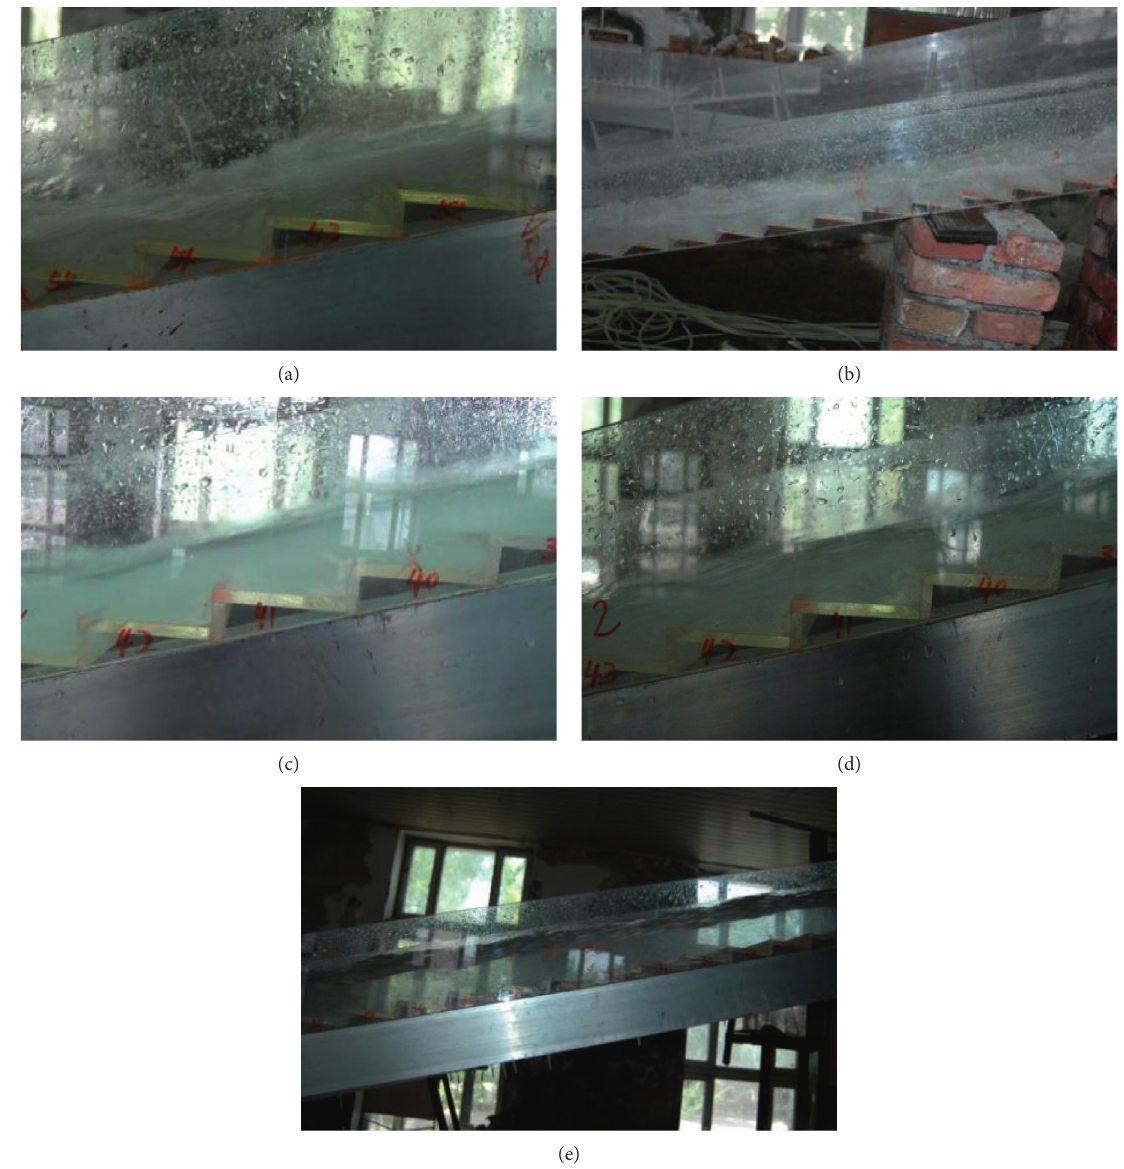
Figure 5: Flow state of water in the ladder section under different conditions. (a) Flow state under a 10-year flood. (b) Flow state under a 20- year flood. (c) Flow state under a 30-year flood. (d) Flow state under the design flood condition. (e) Flow state under collated flood